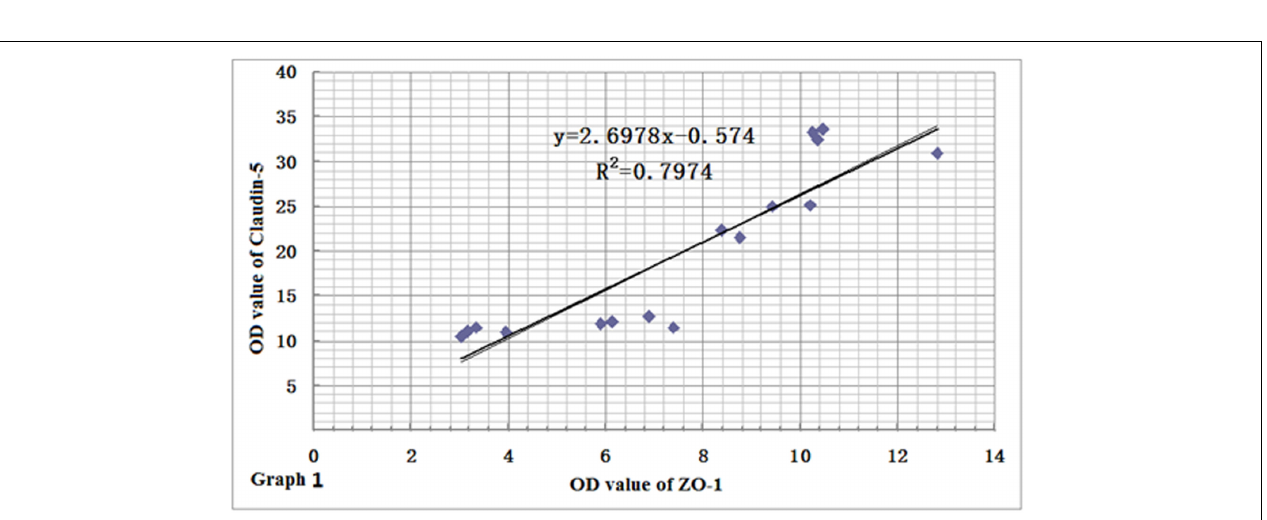
FIGURE 8 | Expressions of ZO-1 and claudin-5 in the same view using double immunofluorescence labeling. (A) ZO-1 positive cells; (B) Claudin-5 positive cells; (C) Co-expression of ZO-1 and claudin-5 proteins (merged image). Scale bar is 30 µ m.